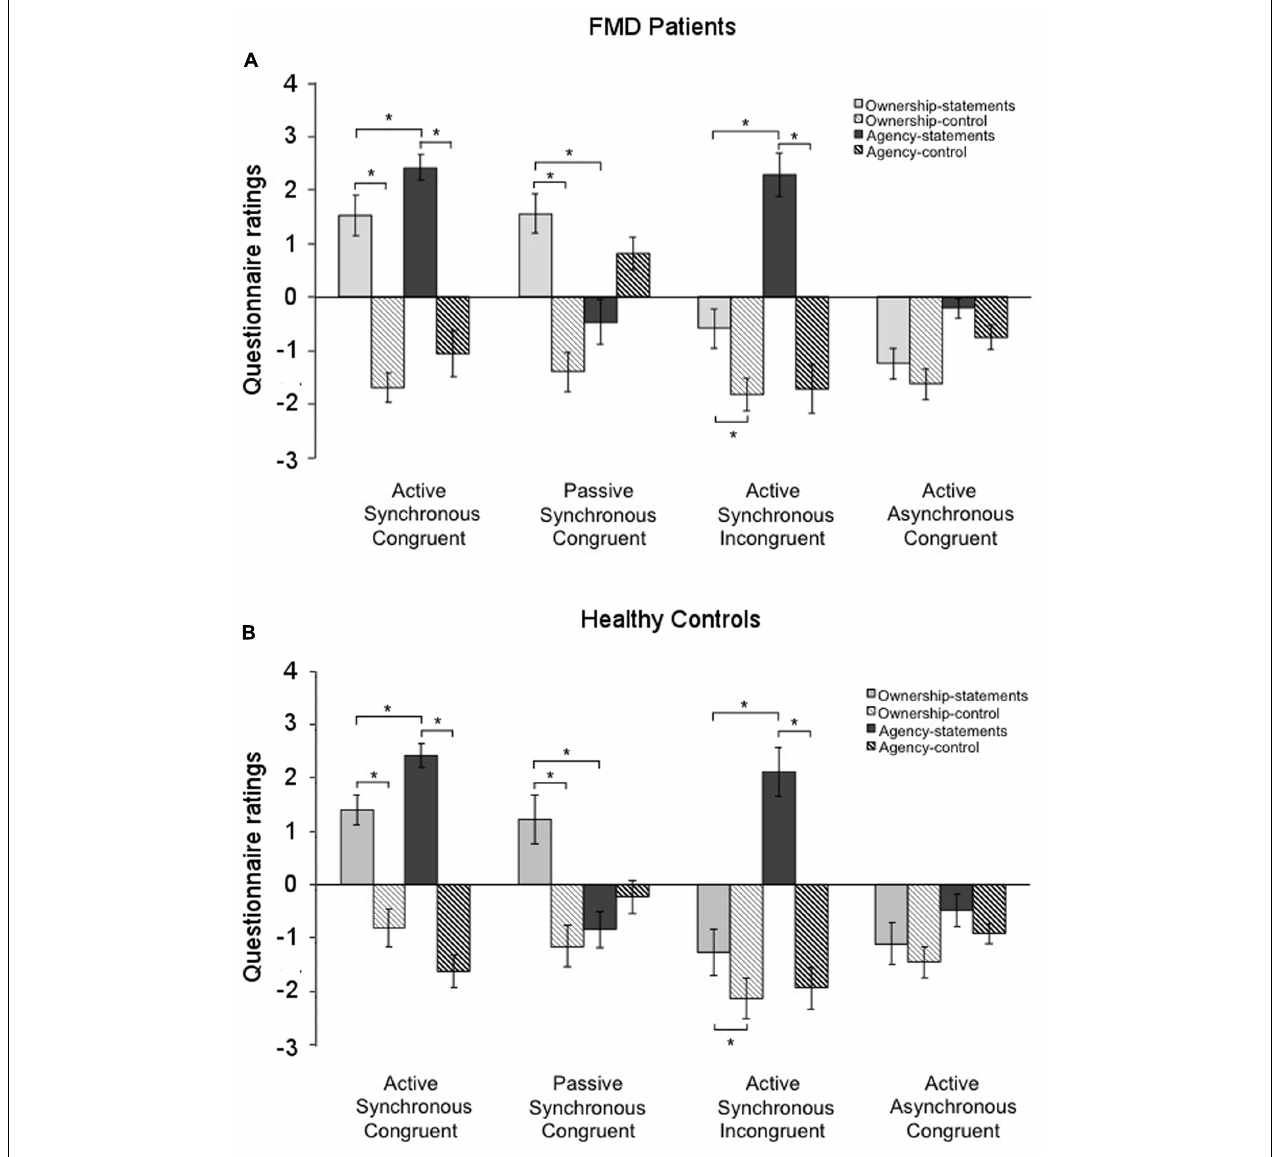
FIGURE 2 | Questionnaire ratings in the two groups. Mean scores for the ownership-statements (light gray columns), ownership-controls (light gray striped columns), agency-statements (dark gray columns), and agency-controls (dark gray striped columns) in the functional movement disorders group (A) and the healthy controls group (B) . Gray lines and asterisks show significant comparisons within conditions. Note that in both groups the Passive Synchronous Congruent condition elicited ownership but not agency, and that conversely the Active Synchronous Incongruent condition elicited agency but not ownership, suggesting a double dissociation between agency and ownership. Error bars indicate standard